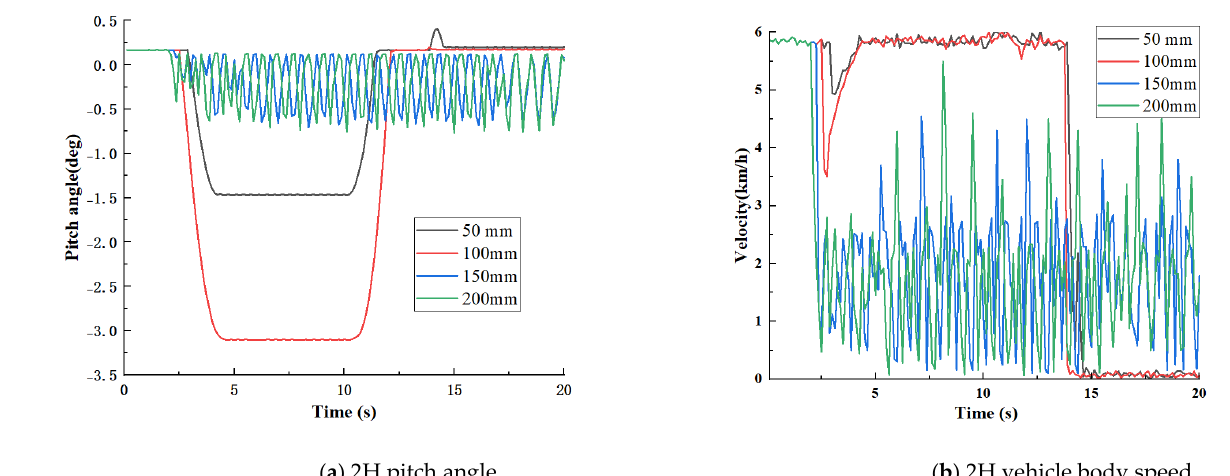
Figure 8. Simulation results of 2H ridge crossing.